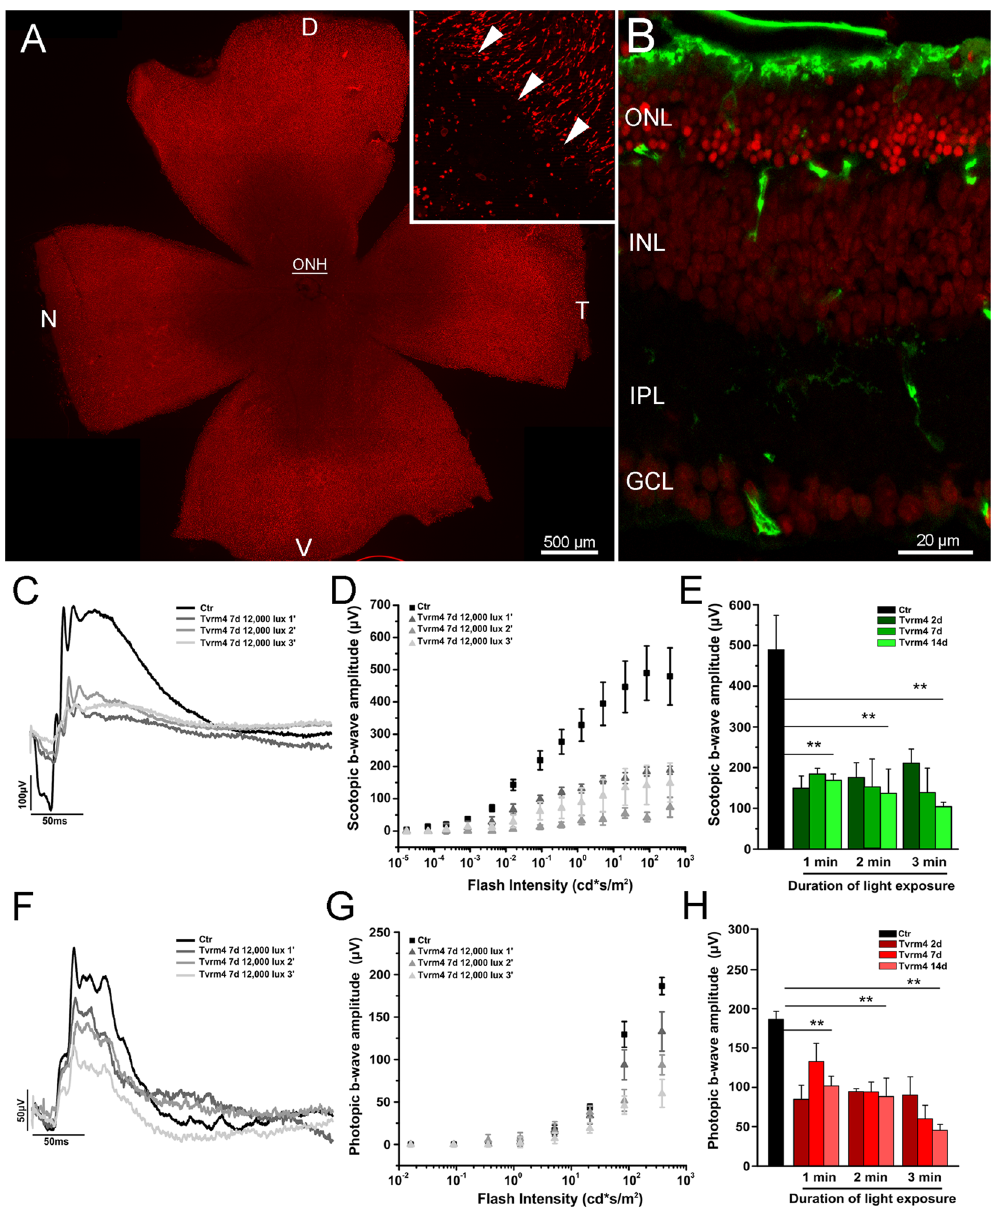
Figure 3. Retinal phenotype 7 days post induction: structure and functional correlation. ( A ) Retinal whole mount from a Tvrm4 mouse exposed to 12,000 lux for 1 min and examined after 7 days. ICCH for short- and medium-wavelength cone opsins (red signal) shows a large area flanking the optic nerve head (ONH) and devoid of cones. Inset: transition margin (arrowheads) between the cone-free central area and a more peripheral zone with still intact cone outer segments. In this and all the whole mount images; D, V, N, T: dorsal, ventral, nasal and temporal retinal quadrants. ( B ) Vertical section from a retinal sample as that shown in A, at intermediate eccentricity between the ONH and the retinal peripheral edge. Green: rhodopsin staining. Red: ethidium staining. The ONL is only 6 rows thick, as opposed to the typical 10–12 rows in the intact retina. Remaining rods have shorter outer segments. Pycnotic nuclei in the innermost part of the ONL indicate active photoreceptor DNA condensation. Representative scotopic ( C ) and photopic ( F ) flash ERG responses recorded from 3 groups of Ht Tvrm4 mice before (black trace) and after (gray traces) exposure to 12,000 lux for 1, 2 or 3 minutes. ERGs were recorded after 7 days. ( C,F ) examples of ERG in response to the brightest flash. ( D,G ): scotopic and photopic b-wave amplitudes as a function of flash intensity in the three experimental groups. ( E,H ) histograms of maximum b-wave amplitude in response to the brightest flash in animals of the three experimental groups. Data were from n = 6 animals/condition. Bars are mean ± SE; ** p < 0.01 one-way ANOVA. Scotopic brightest flash: 83.7 cd * s/m 2 ; photopic brightest flash: background 30 cd/m 2 + superimposed flash 377 cd * s/m 2